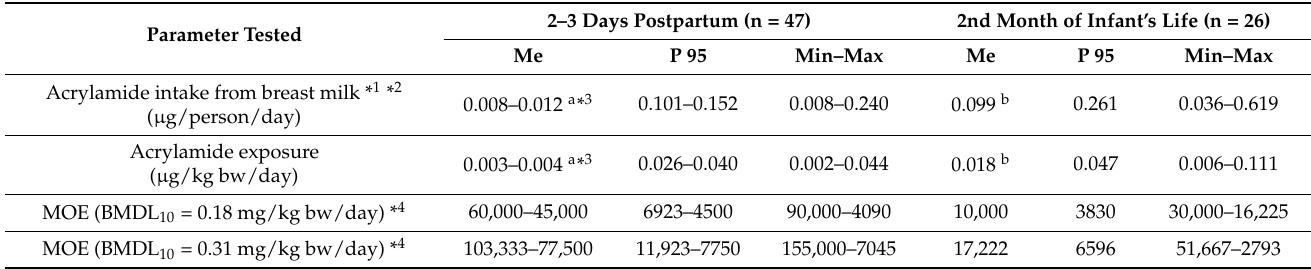
Table 5. Estimated exposure of infants to acrylamide in breast milk and margins of exposure (MOE). Parameter